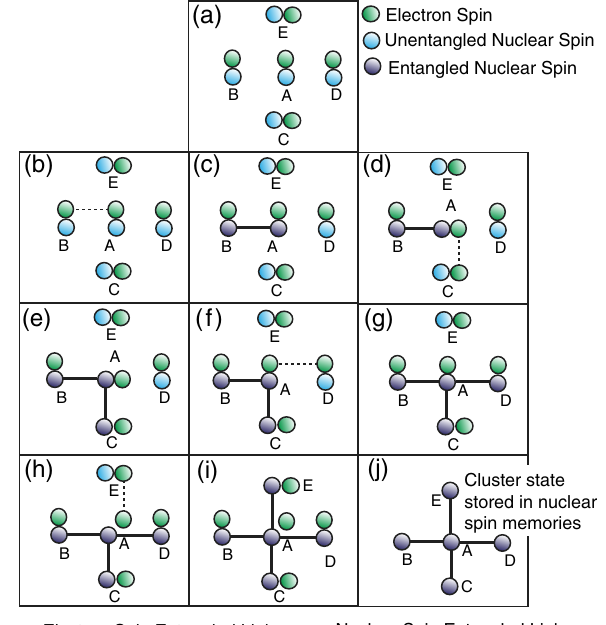
FIG. 4. Illustration of the sequence of operation to create a cluster state of five nuclear spin qubits. The scheme uses the repeat-until-success approach to create entanglement between two electron spins, before transferring upon success such en- tanglement to the corresponding nuclear spins.